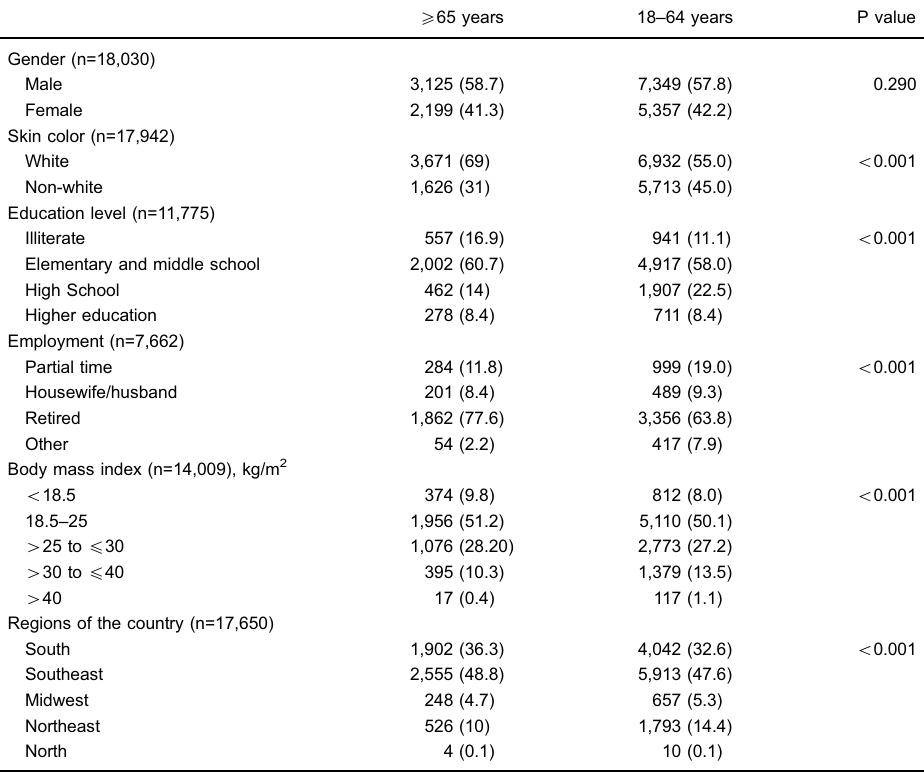
Table 1. Sociodemographic characteristics of dialysis patients by age